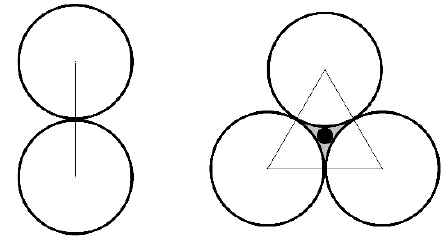
Figure 1. The particle-connection and the void cell.